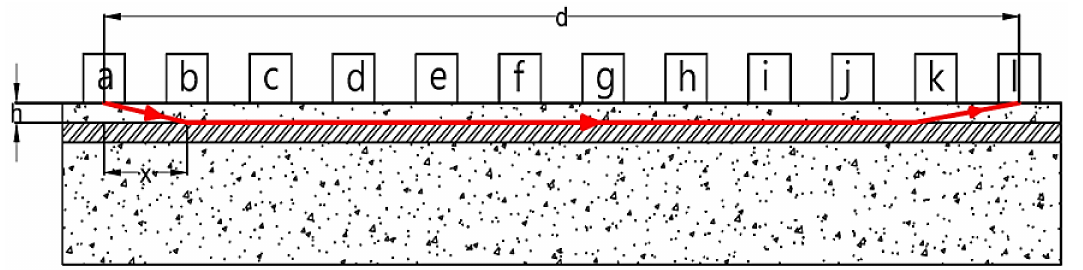
Figure 4. The pathway of the wave under the presence of a steel